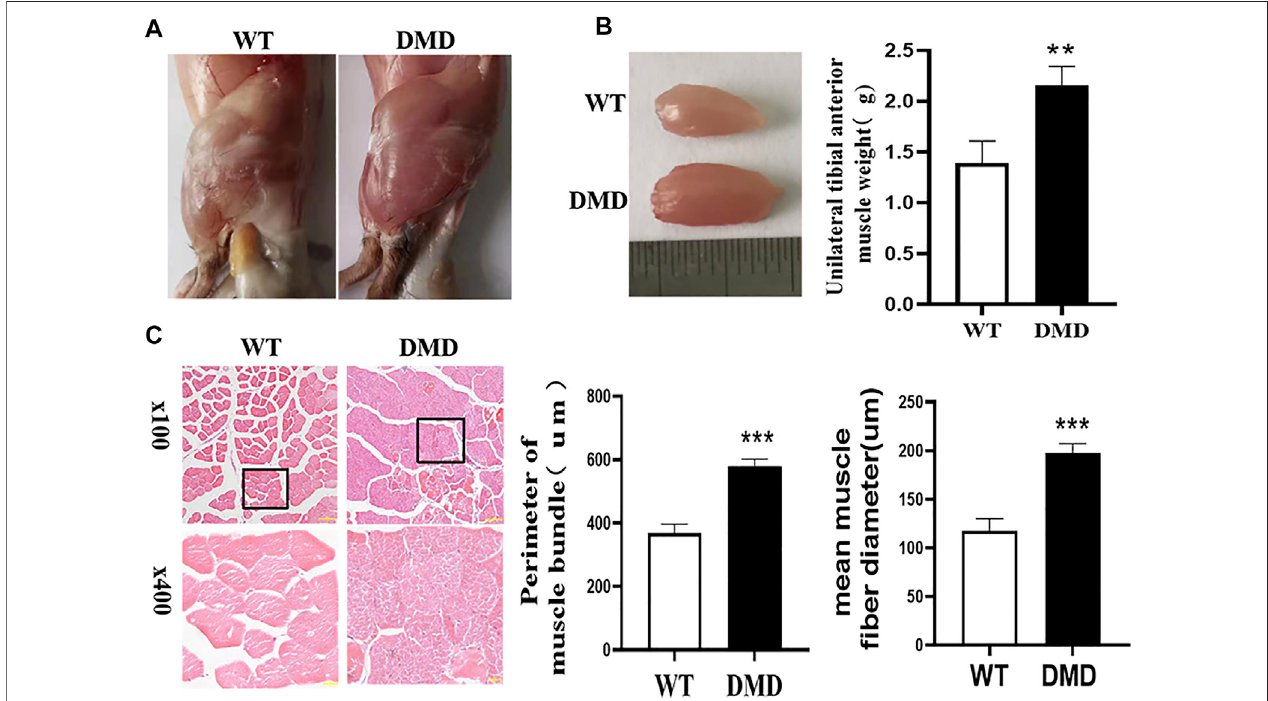
FIGURE 1| Hypertrophy of tibialis anterior in DMD Mice. (A) Overview oflower limb muscles in DMD mice and WT mice. (B) The isolated tibialis anterior of WT and DMD, the average weight of unilateral isolated tibialis anterior was measured in DMD and control mice. Data were presented at means ± SEM ( n = 6) with independent sample t -test. ** p < 0.01. (C) HE staining of bundles on TA. The average circumference of the tibialis anterior was measured in 10 different fi elds. Quanti fi cation and comparison in the mean diameter of the ferret for myo fi bers were performed. Data were presented at means ± SEM ( n = 6) with independent sample t -test. *** p <